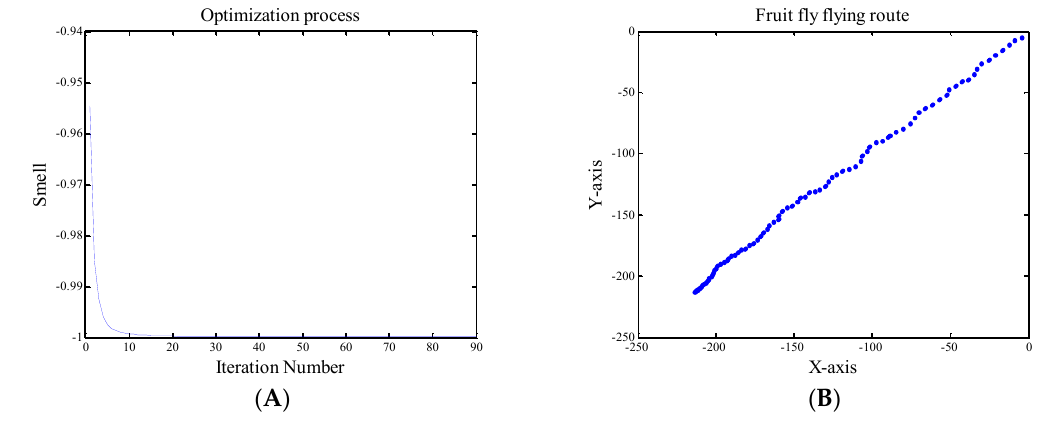
Figure 10. ( A ) Optimization process of FOA3; and ( B ) fruit fly flying route of FOA3.